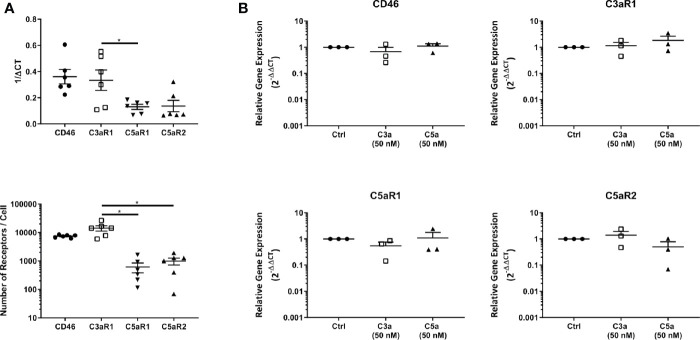
Baseline expression, quantitation and modulation of complement receptors. (A) Complement receptor expression in untreated mast cells determined by qPCR (above) and fluorescence quantitation (below). Data are mean ± SEM of n=6 experiments from 9 pooled donors and 6 individual donors respectively. (B) qPCR expression of complement receptors 8 h after addition of C3a (50 nM), C5a (50 nM), or media control. Data are mean ± SEM of n=3 independent experiments from three donors. Significant differences are indicated by * = p<0.05 (ANOVA with Dunnett’s post-test). Summary statistics are presented in the
Supplementary Material
.